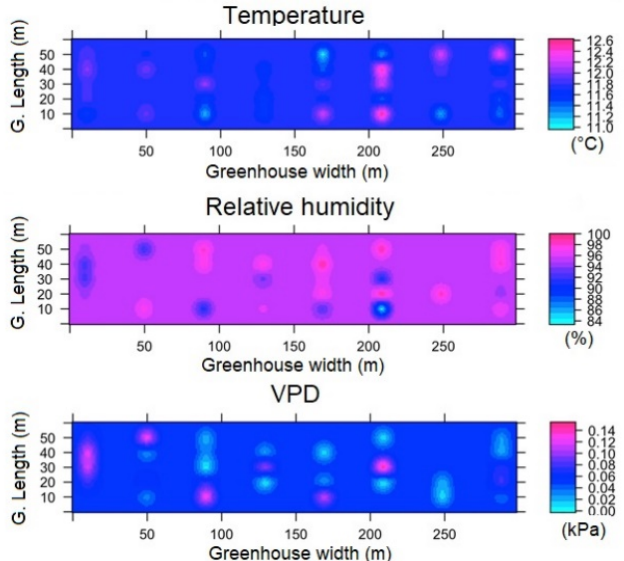
Figure 11. Spatial distribution predicted by kriging, for temperature, relative humidity and VPD in SG and for ESRL 1.